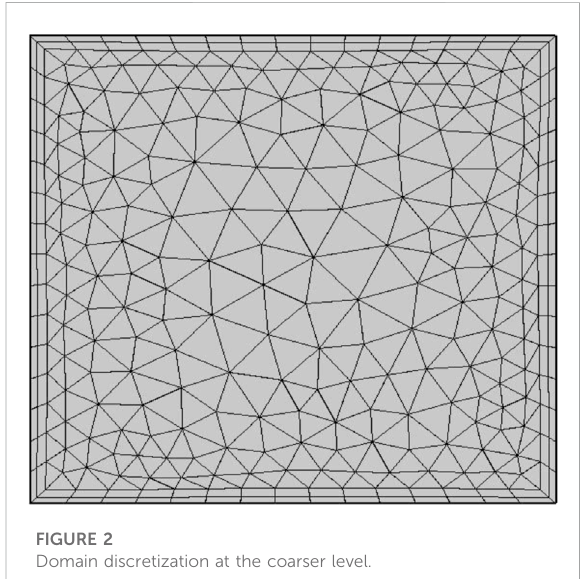
FIGURE 2 Domain discretization at the coarser level.